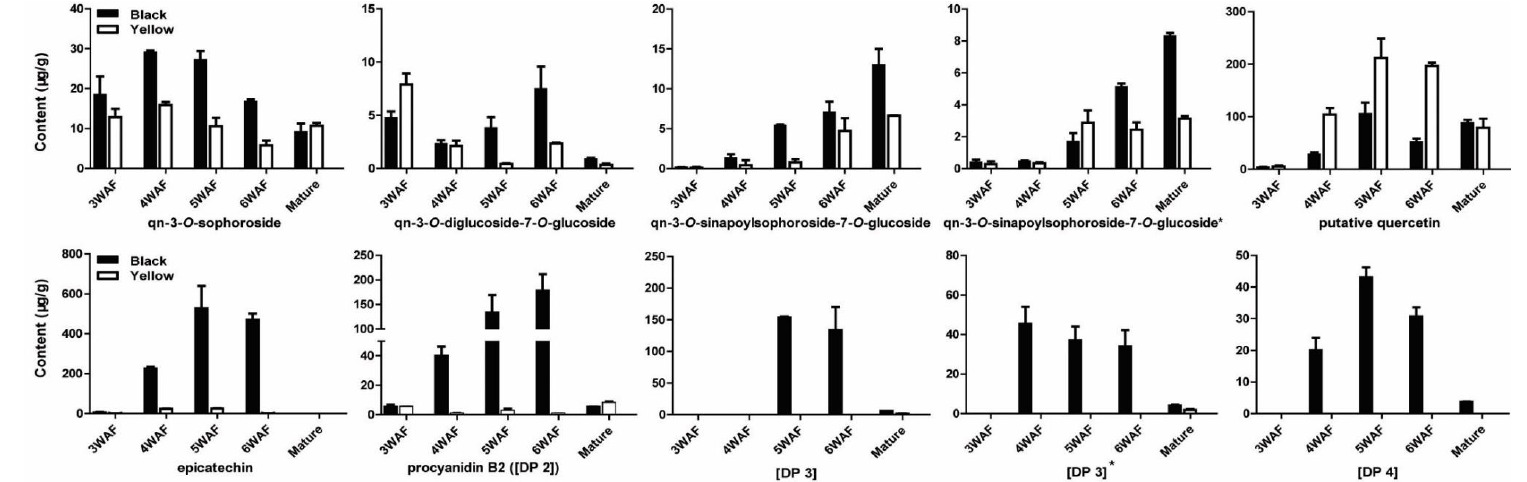
Figure 6. Accumulation pattern of quercetins, epicatechin and derivatives in yellow and black rapeseed. qn, quercetin; DP, degree of polymerization of the epicatechin unit; WAF, week after flowering.